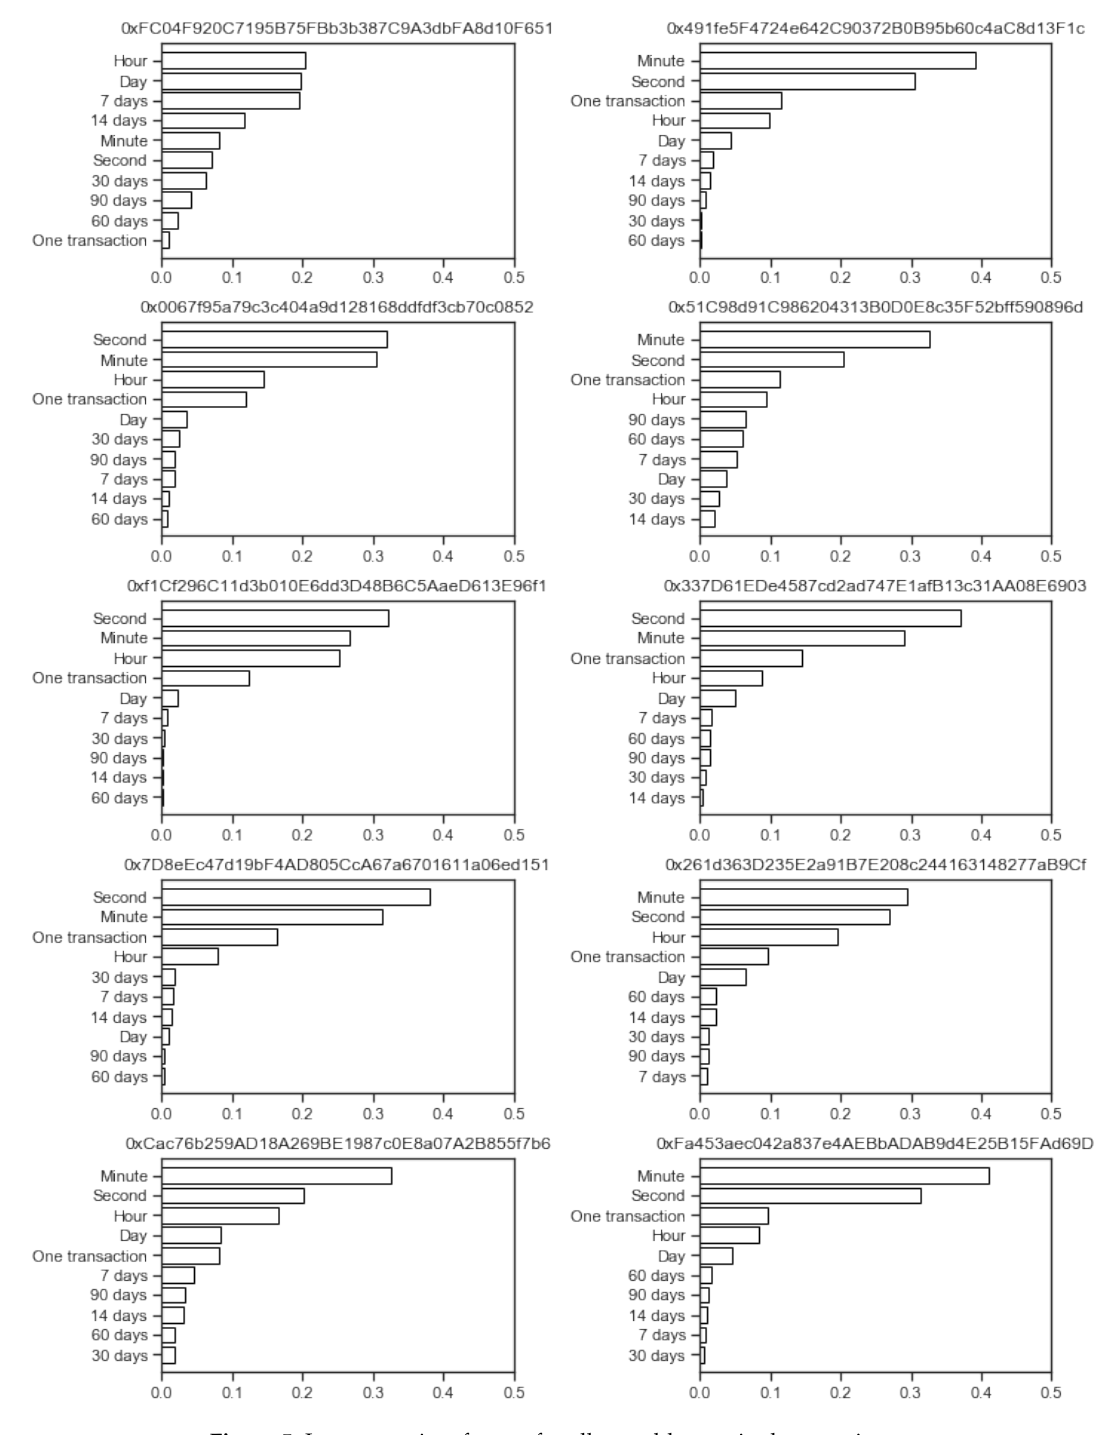
Figure 5. Important time frames for all ten addresses in the